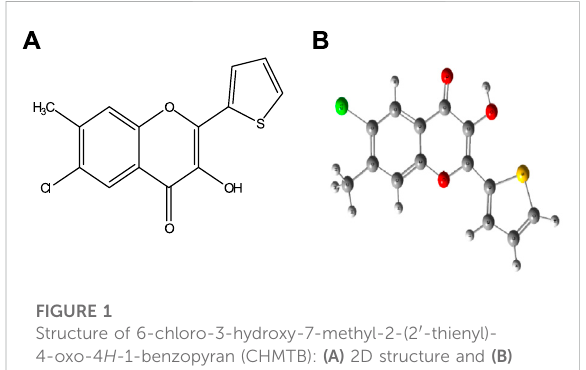
FIGURE 1 Structure of 6-chloro-3-hydroxy-7-methyl-2-(2 ′ -thienyl)- 4-oxo-4 H- 1-benzopyran (CHMTB): (A) 2D structure and (B) optimized structure.